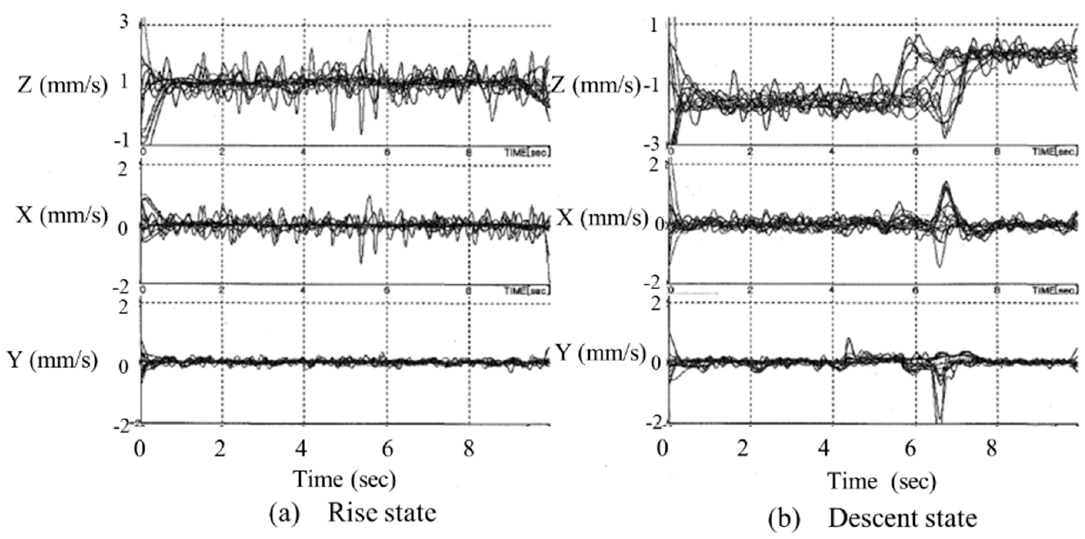
Figure 25. Measurement results of the velocity of 10 microrobots in the ( a ) climbing and ( b ) descending states. The velocity in the Z -direction when descending is twice that when climbing. The velocity change in the Y -direction is small compared to the other two directions as the movement of the microrobots is restricted by the cylinder wall. The velocity fluctuation in the three directions is high in the time range between 0 and 1 seconds.